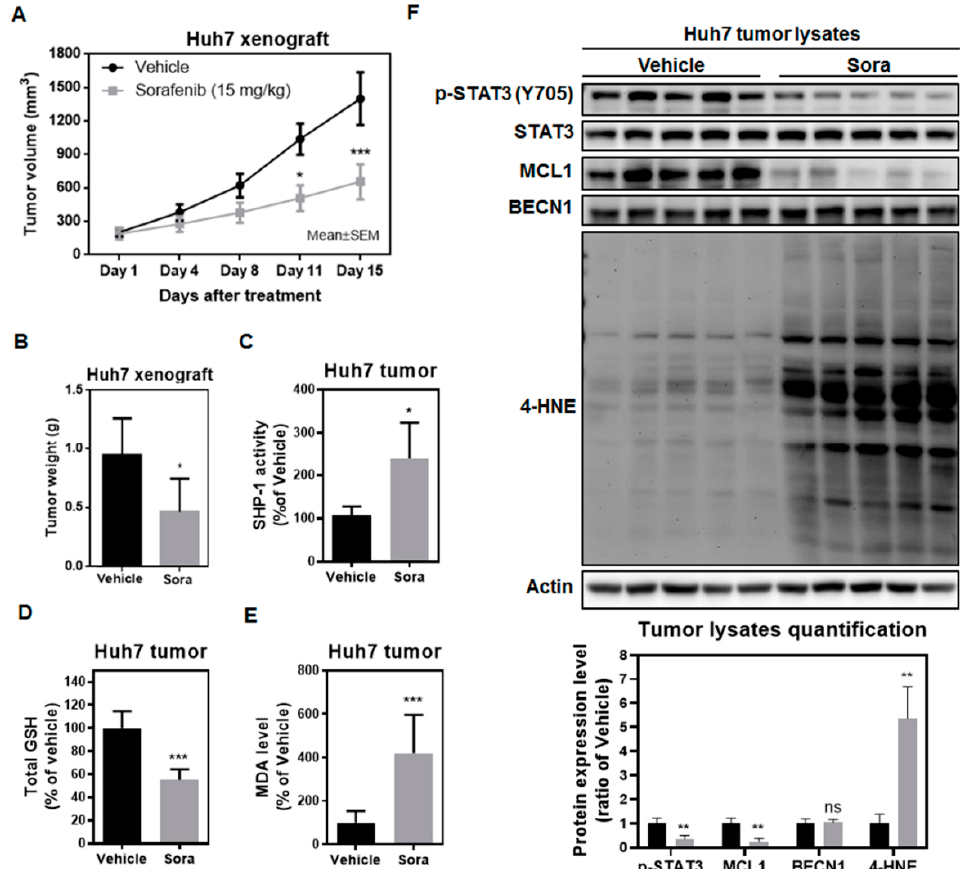
Figure 7. Sorafenib treatment enhances SHP-1 activity, inactivates STAT3, reduces MCL1 expres- sion, and triggers ferroptosis in the Huh7 murine model: ( A ) Sorafenib inhibited tumor growth in Huh7 tumor-bearing mice. Sorafenib was orally administered five times per week, and the tumor volumes were measured twice weekly. Points: mean; bars: standard error of the mean (SEM) (n = 7). Statistical significance was evaluated by two-way ANOVA (*, p < 0.05; ***, p < 0.001). ( B ) At the end of the treatment, the Huh7 tumors were excised, and the tumor weights were recorded. ( C ) SHP-1 activities were measured using Huh7 tumor lysates from the mice treated with sorafenib or vehicle. ( D ) Total GSH levels and ( E ) MDA levels were evaluated using Huh7 tumors collected from the mice treated with sorafenib. ( F ) The protein expression levels (upper panel) and the quantification results (lower panel) of p-STAT3 (Y705), STAT3, MCL1, BECN1, and 4-HNE adducts were examined via Huh7 tumor lysates acquired from sorafenib-treated mice. Columns: mean; bars: SD (n ≤ 7). Statistical significance was determined by using the Mann–Whitney U test (*, p < 0.05; **, p < 0.01; ***, p <